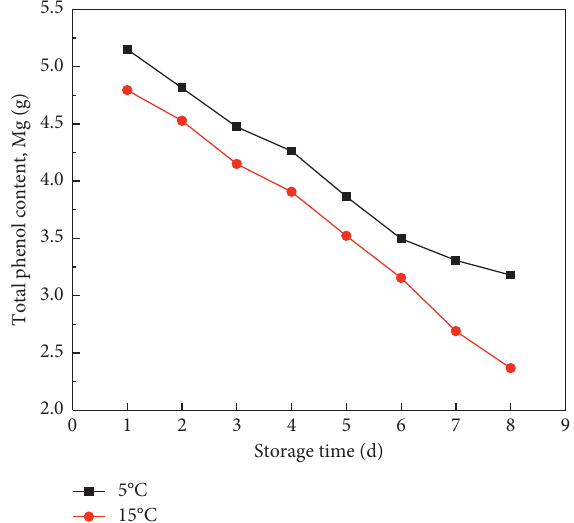
Figure 5: Analysis results of total phenol content in potato